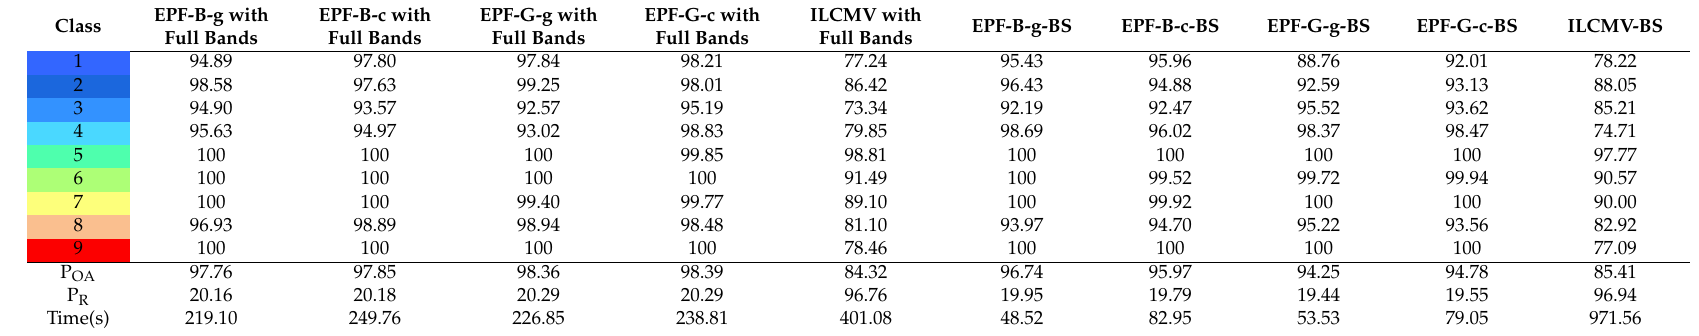
Table 14. P OA and P R calculated by the classification results using full bands and the bands selected by SQ LCMV-BSS-2 in Table 2 for University of Pavia.